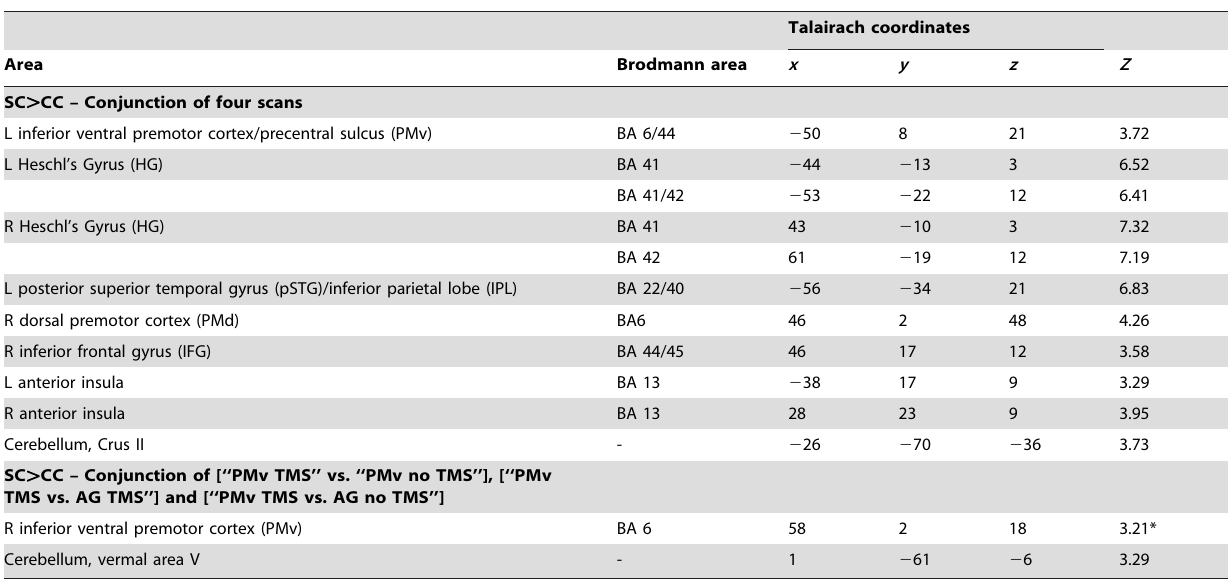
Table 1. Anatomical specification, hemisphere (R right, L left), Talairach coordinates (x, y, z), volume (mm3) and maximal Z scores ( Z ) of significant activations in the direct contrasts.